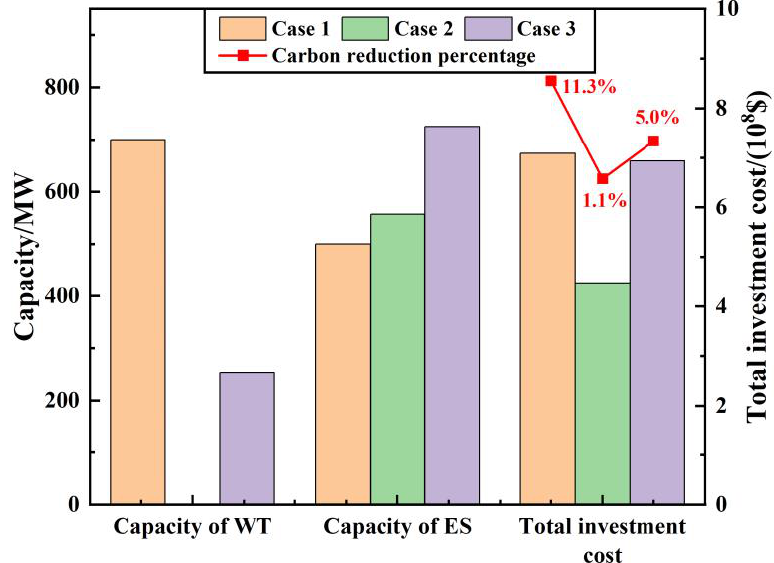
Table 7. Planning results of different cases in Scenario 1.